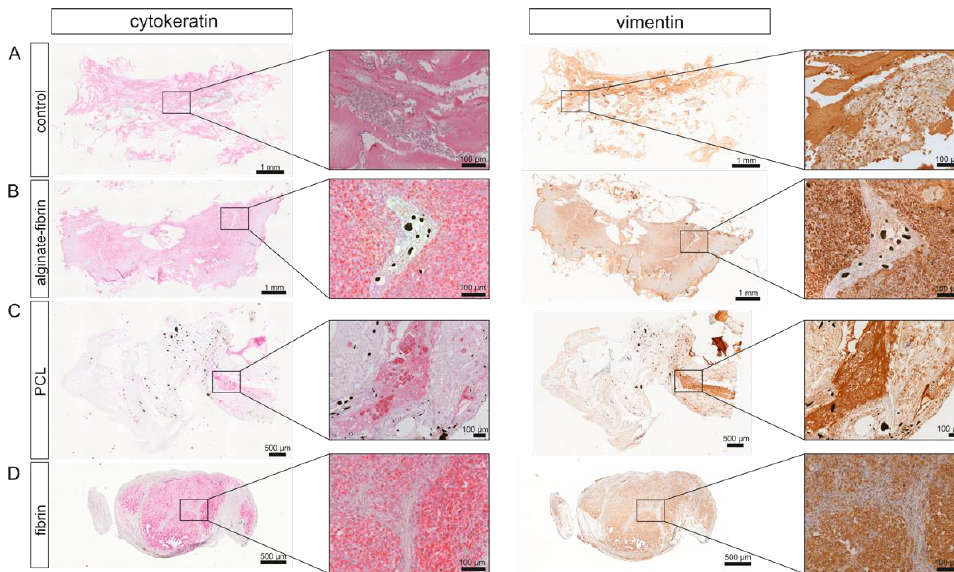
Figure 5. Immunohistochemical staining for cytokeratin and vimentin in the constructs. Representa- tive images of cytokeratin and vimentin immunohistochemical staining in control ( A ), alginate–fibrin ( B ), PCL ( C ), and fibrin ( D ) groups presented at low magnification (40×) and high magnification (200×). Black arrows indicate the cytokeratin-positive cells. Yellow arrows indicate the vimentin- positive cells.